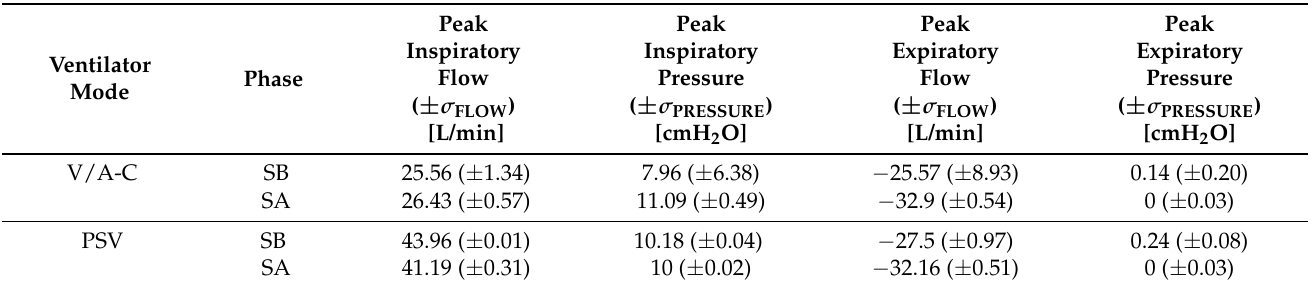
Table 2. Patient–ventilator interaction. Differentiation between phases: (1) spontaneous sinusoidal breathing (SB) and (2) simulated apnea (SA) for both V/A-C and PSV mode with a breathing frequency of 12bpm.